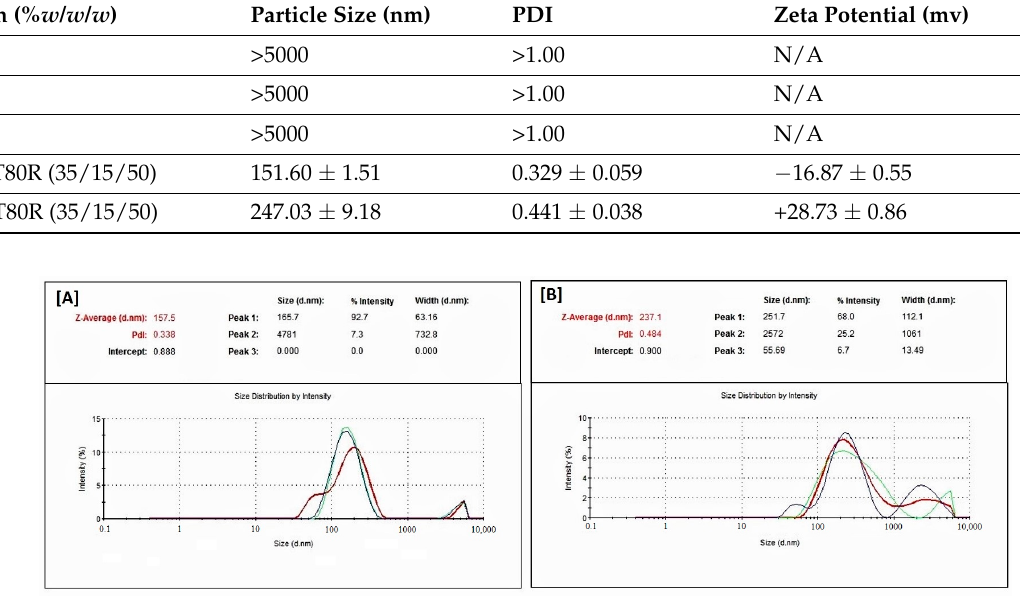
Table 5. Particle size distribution data, PDI, and zeta potentials of the Bio-SNEDDS. Data are expressed as mean ± SD, n = 3.